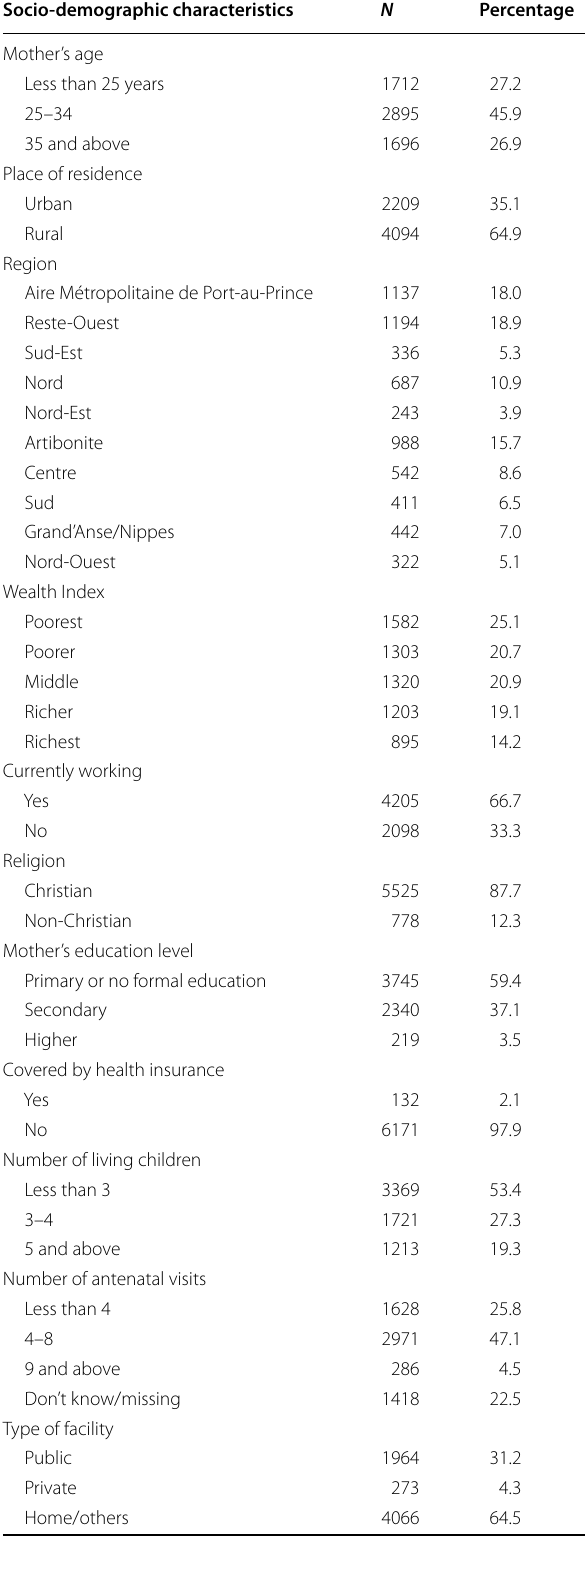
Table 1 Socio‑demographic profile of the population